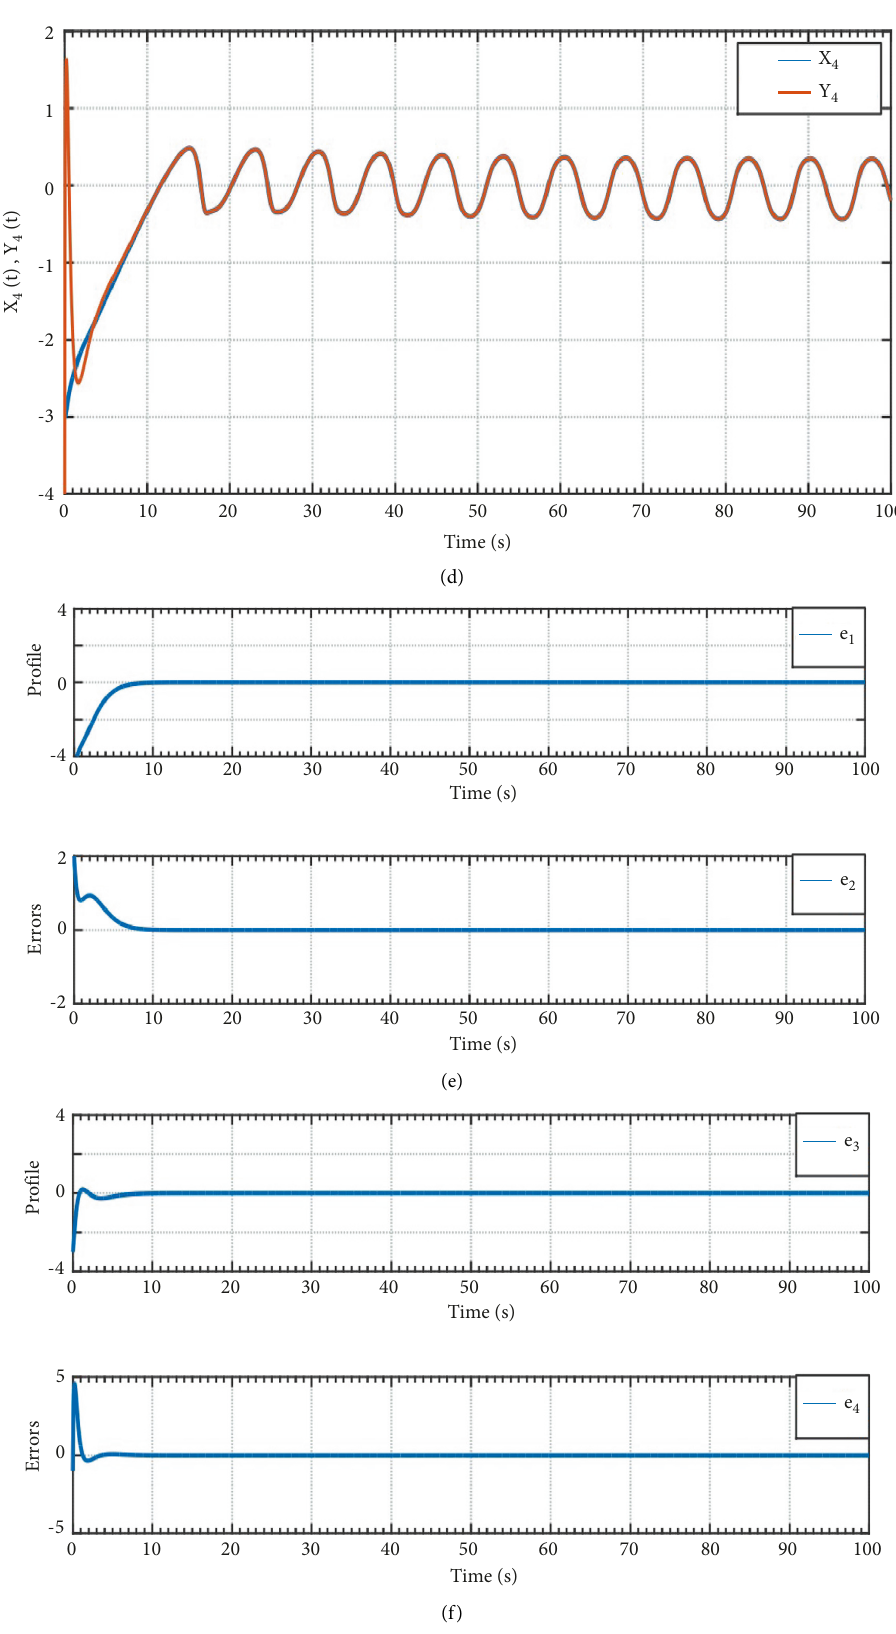
Figure 5: Synchronization of identical 4D hyperchaotic financial system with adaptation of parameters. (a) Synchronization of interest rate corresponding to the initial condition [ x ( 0 ) , y ( 0 ) � ( 1 , 3 )] . (c) Synchronization of price index corresponding to initial condition [ x condition [ x 2 2 Synchronization of average profit margins corresponding to the initial condition [ x , e ,e , and e errors e 1 2 3 4